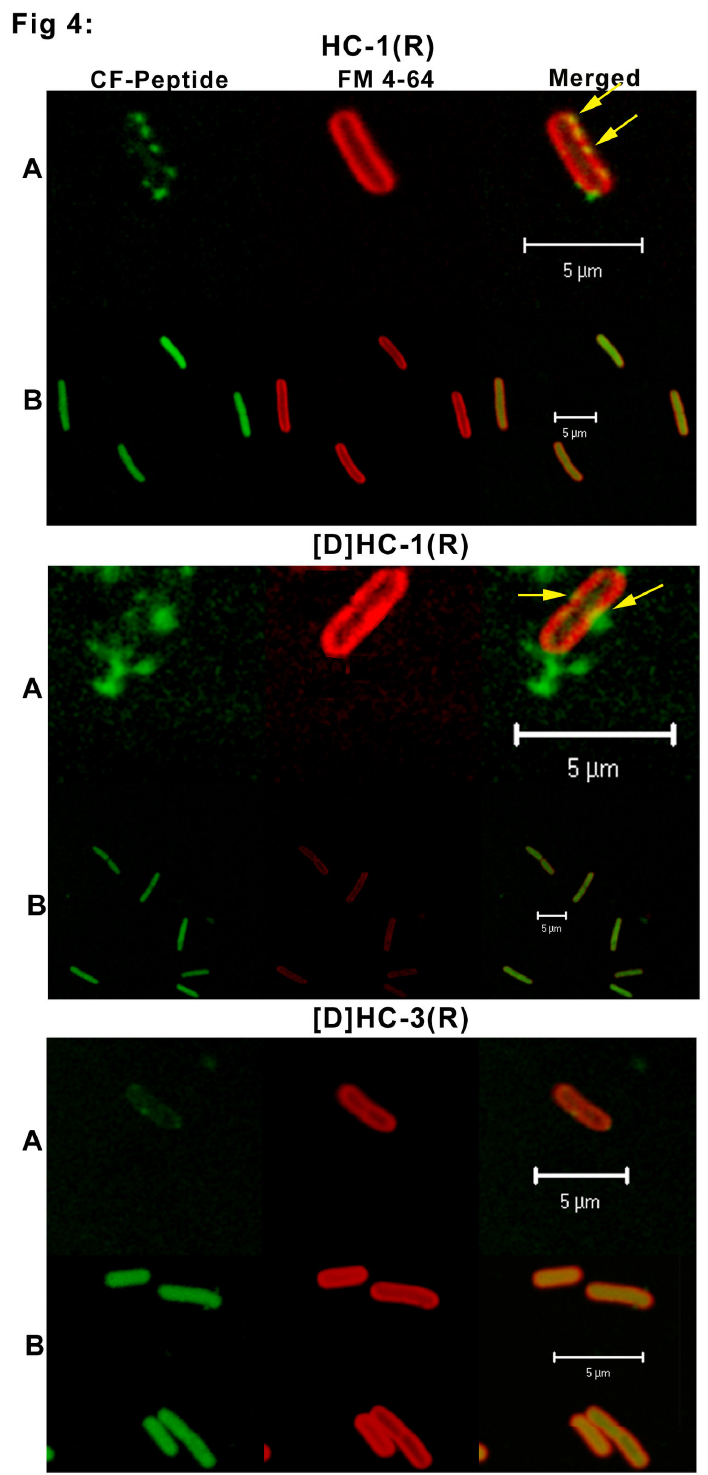
Figure 4. Confocal microscope images of E. coli in the presence of CF-labeled HC-1(R), [D]HC-1(R) and [D]HC-3(R). Bacterial cells (1 x 10 7 ) were treated with CF labeled peptide and FM4-64 and were incubated for different time points. Panel A represents an early time point where the peptide interacts with the bacterial membrane. Panel B represents a late time point wherein the peptide is found completely diffused inside the cell. The bar represents 5 µm. doi: 10.1371/journal.pone.0077031.g004 PLOS ONE |